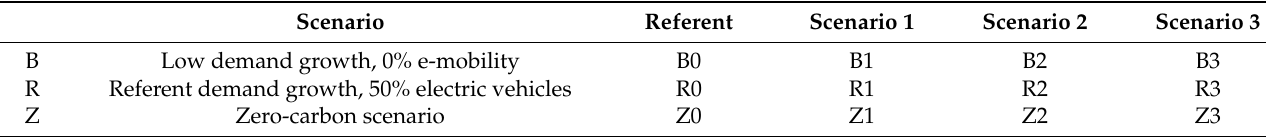
Table 3. Sensitivity analysis